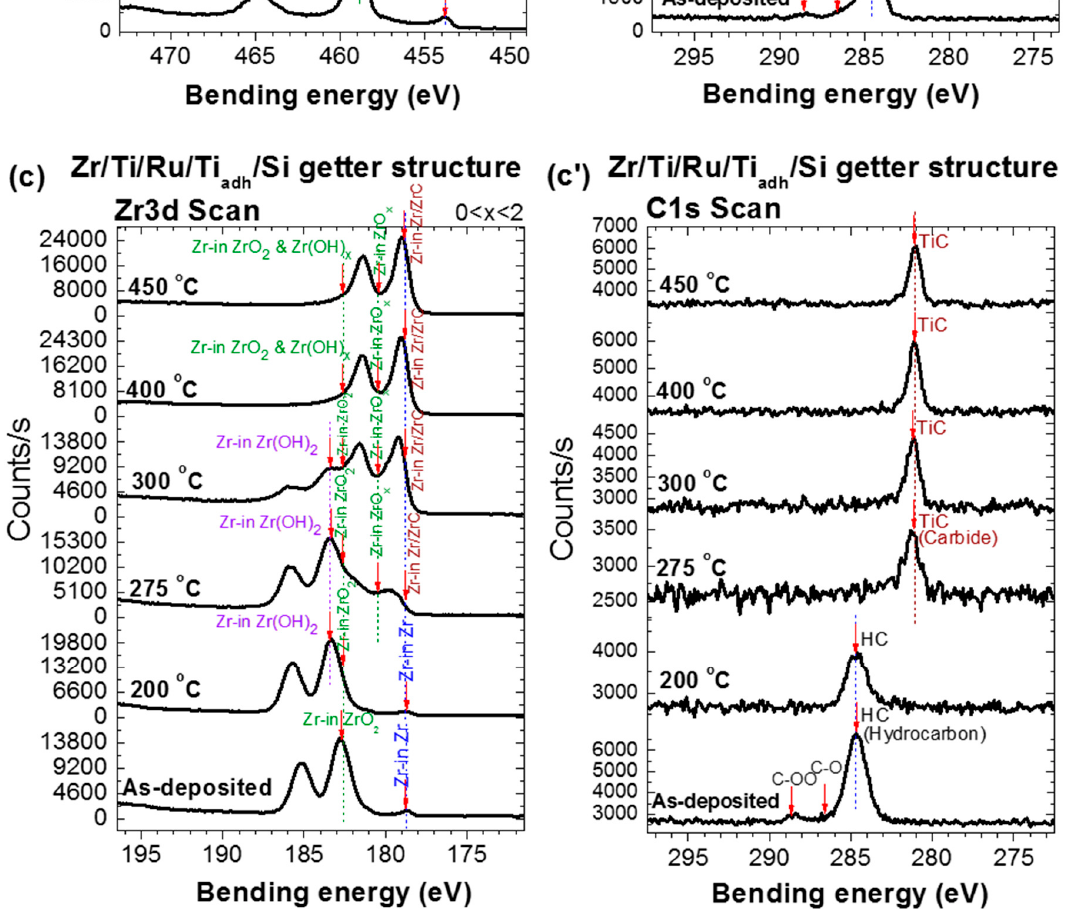
Figure 3. Evolution of XPS spectra after activation at various temperatures. ( a , a’ ) Ti 2p and C 1s orbitals for the single layer Ti/Si NEG; ( b , b’ ) Ti 2p and C 1s orbitals for the multilayer Ti/Ru/Si NEG; ( c , c’ ) Zr 3d and C 1s orbitals for the multilayer Zr/Ti/Ru/Si NEG.